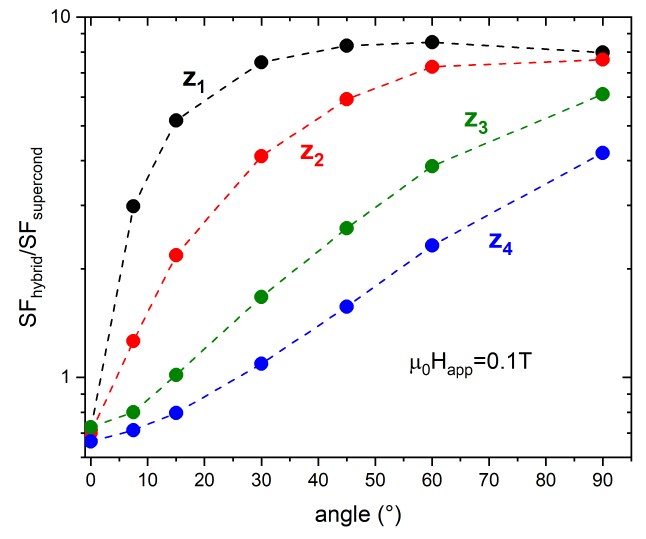
Figure 8. Dependence of the ratio between the SFs of the configuration HTC3 and those of the single SC tube, SF hybrid / SF supercond , on the tilt angle of the applied magnetic field having magnitude 0.1 T. The data refer to positions z 1 (black dots), z 2 (red dots), z 3 (green dots), and z 4 (blue dots).